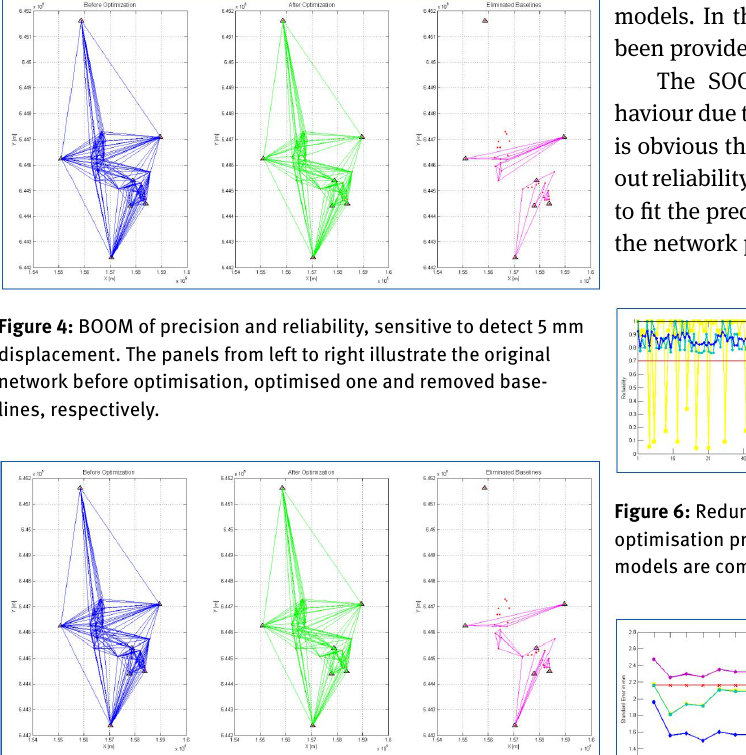
Figure 5: MOOM of precision, reliability and cost, sensitive to de- tect 5 mm displacement. The panels from left to right illustrate the original network before optimisation, optimised one and removed baselines, respectively.